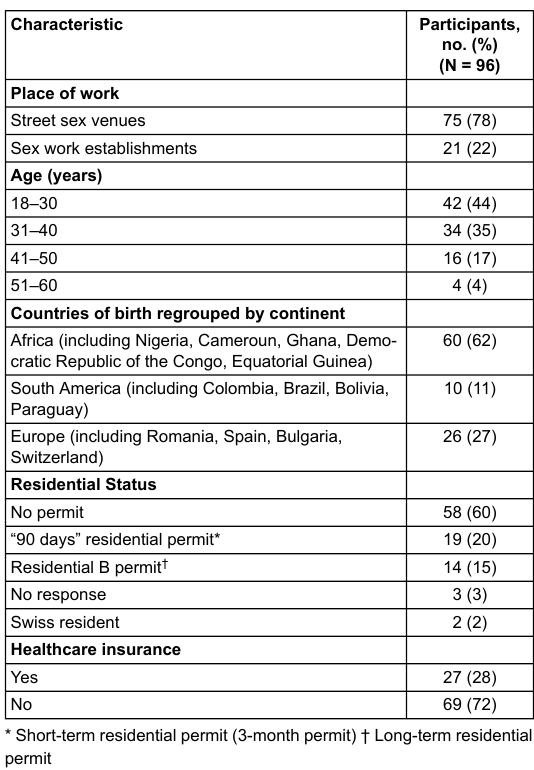
Table 1: Demographic characteristics of participants. The study was performed from 1 April 2015 to 31 December 2016 in Lausanne, Switzerland.